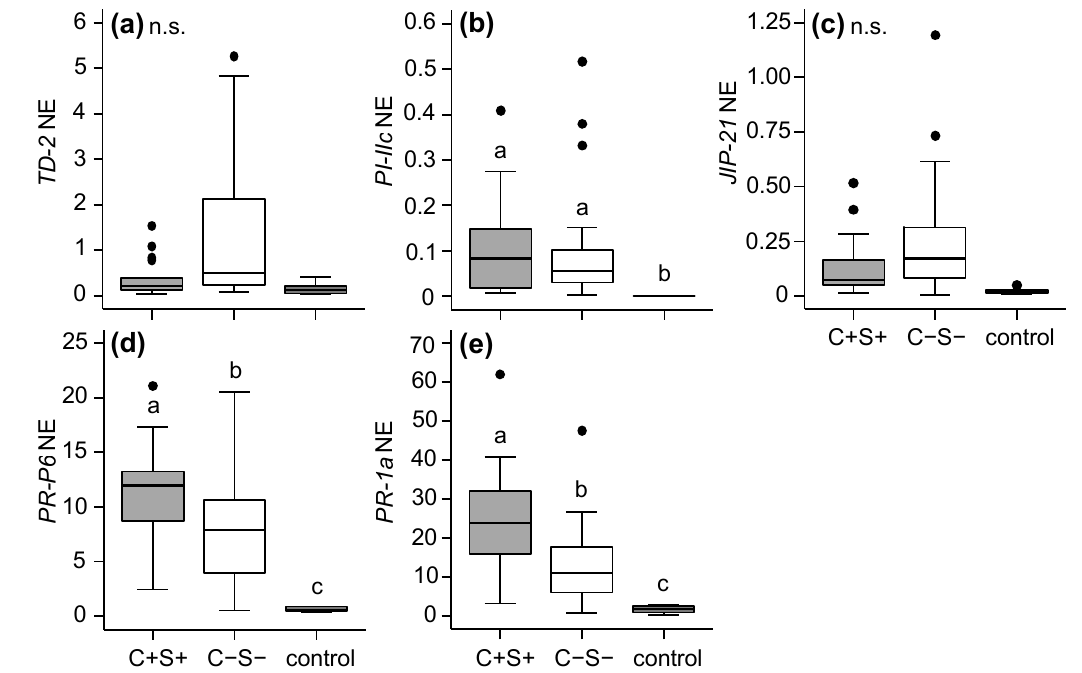
Figure 6. Normalized expression (NE) of plant defence related genes obtained via qRT-PCRs in tomato ( S. lycopersicum ) leaflets after seven days of infestation with the spider mite T. urticae Santpoort-2 strain which did (+) or did not ( − ) contain the bacteria Cardinium (C) and Spiroplasma (S). Control plants were not infested. ( a ) TD-2 ; ( b ) PI-IIc ; ( c ) JIP-21 ; ( d ) PR-P6 ; and ( e ) PR-1a ; Gene expression levels were normalized to the levels of tomato actin . Boxes span the 25–75 percentiles, horizontal lines in the boxes represent medians, whiskers span 1.5× IQR, dots represent data points outside of this range. Different letters above the boxes indicate significant differences at a level of p ≤ 0.05, after applying linear mixed models followed by Tukey multiple comparisons with Holm adjustment. n.s.: not significant